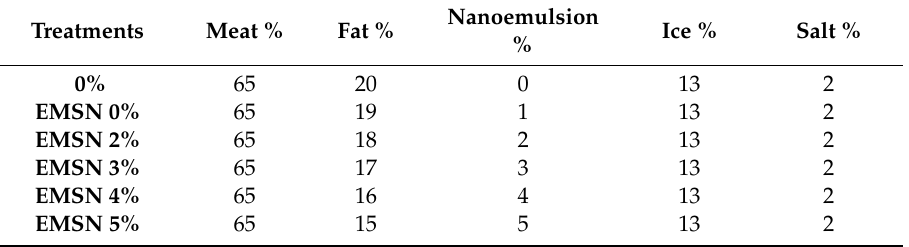
Emulsified meat system with nanoemulsion